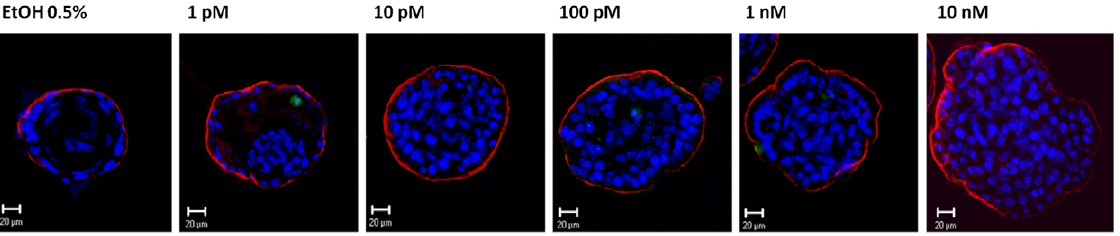
Figure 3. Dose-response analysis of 3D cultures of MCF-12A cells grown in Matrigel for 16 days in the presence of E2. Cells were either incubated with solvent (ethanol 0.5%) or with increasing concentrations of E2. Resulting samples were treated with antibodies against laminin V (red), activated caspase-3 (green) and nuclei visualized with To-PRO 3 (blue), and subsequently analysed by confocal microscopy. Images are representative of each one of the treatments and 3 independent experiments.